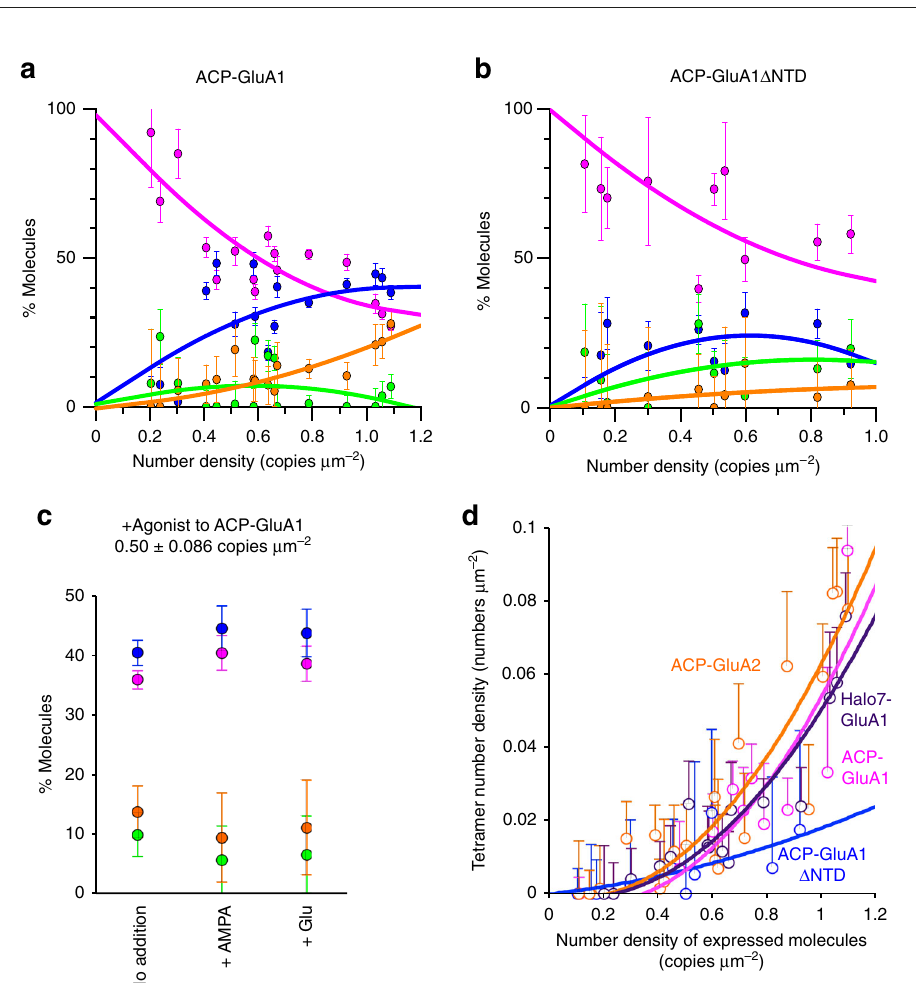
Fig. 1 GluA1 existed as monomers, homodimers, and homotrimers as well as homotetramers when expressed in the HEK293-PM. Note that most of the data about GluA2 are shown in the Supplementary Information. a Schematic fi gure showing the structures of ACP-GluA1, ACP-GluA1 Δ NTD, ACP-GluA2, and ACP-TM. LBD represents the ligand-binding domain. Representative snapshot images and distributions (histograms) of the signal intensities of individual fl uorescent spots of ATTO594-labeled ACP-TM ( b ) and ACP-GluA1 ( c ) expressed in HEK293-PMs. Distributions of the signal intensities of individual fl uorescent spots (histograms) were obtained at various expression levels (number densities). The numbers of examined fl uorescent spots: 779, 1729, and 2192 spots for ACP-TM (from left to right in b and 4305, 7730, and 7107 spots for ACP-GluA1 (from left to right in c ). Each distribution was fi tted with the sum of two (for ACP-TM, b ) or four (for ACP-GluA1, c ) lognormal functions, representing the fractions of monomers (magenta), homodimers (blue), homotrimers (green), and homotetramers (orange). Numbers in the fi gure indicate molecular fractions. Magenta arrowheads and yellow arrows in the images indicate spots with fl uorescence intensities of <3.6 and >3.6 arbitrary units (A.U.). This threshold intensity was determined as that at which the ratio of the copy numbers of ACP-TM with higher vs. lower intensities in the experimental histogram became the same as the ratio of apparent dimers vs. monomers determined by the lognormal fi tting. Related ACP-GluA2 results are shown in Supplementary Fig. 3b